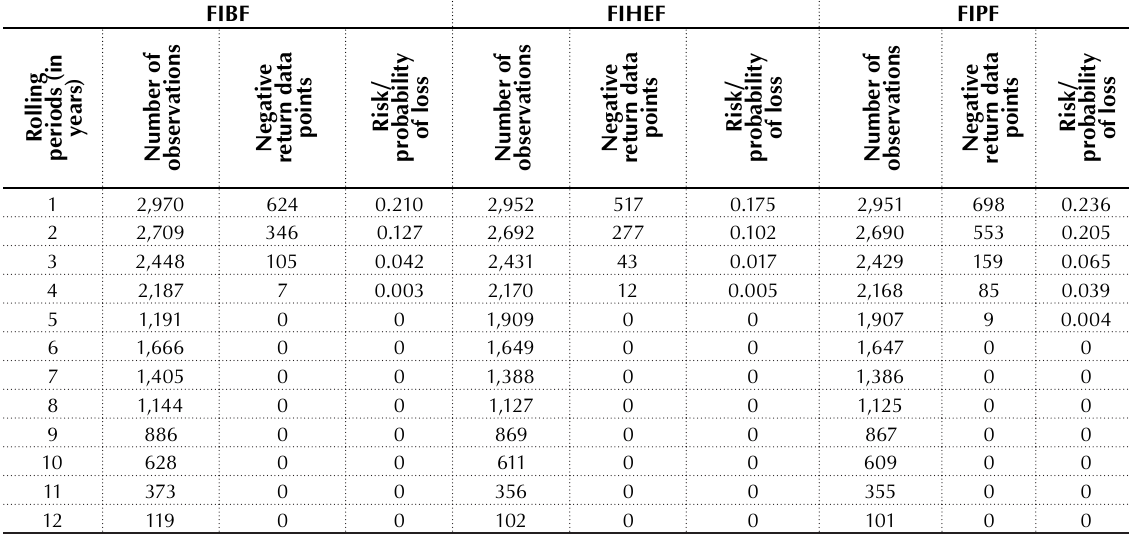
Table 15. Rolling period risk and return behavior of FIBF, FIHEF and FIPF (2006–2018)